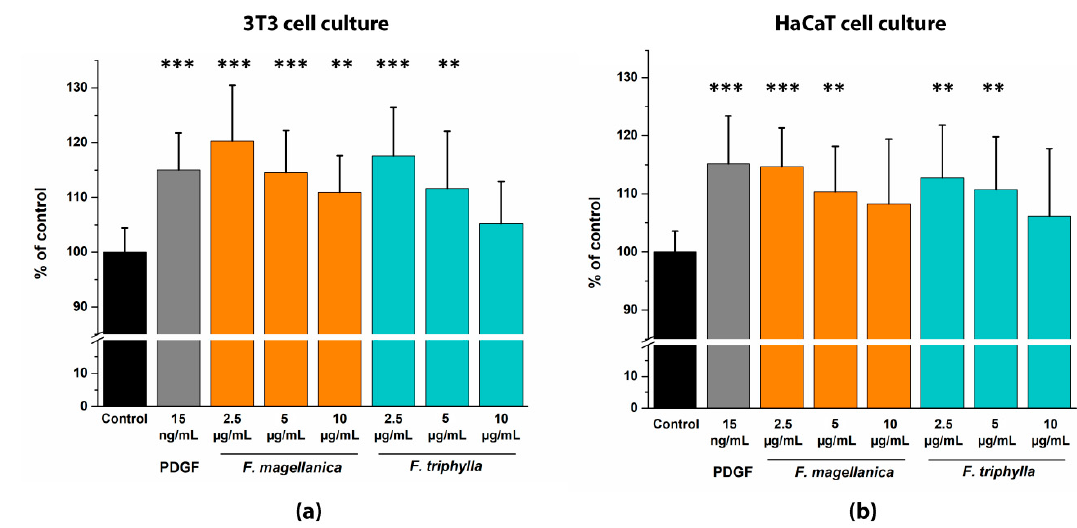
Figure 7. Comparative analysis by time-lapse imaging of wound closure ability of PDGF-BB and plant extracts on HaCaT monolayer. ( a ) 50% ( v / v ) ethanolic extracts of F. magellanica and F. triphylla on 3T3 monolayer cells; ( b ) 50% ( v / v ) ethanolic extracts of F. magellanica and F. triphylla on HaCaT monolayer cultures. Cells were monitored for 24 h in the absence and in the presence of plant extracts or PDGF with phase contrast microscopy. The bar graphs of AUC were calculated from cumulative closure rates (CR %) studied at every 4 h with three di ff erent concentrations from each plant. Mean ± SD of three independent experiments. n = 3 × 3 replicates. One-way Anova test (** p < 0.01, *** p < 0.001 compared with control).